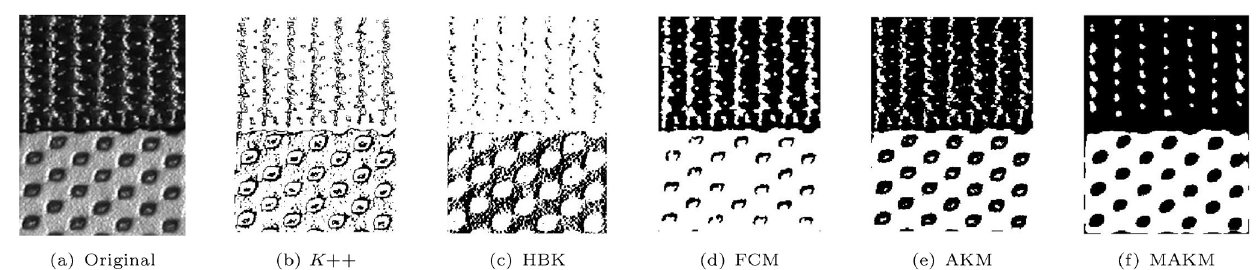
Fig. 3 Bag-labeled image segmented using various